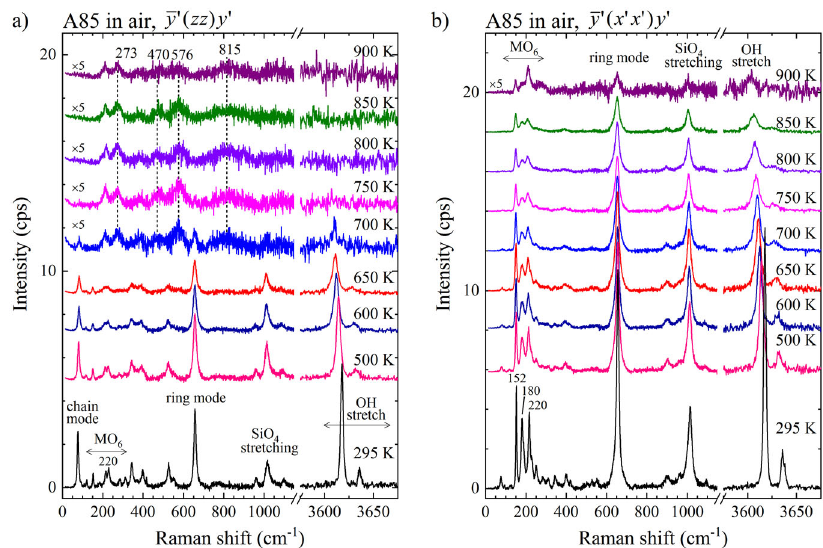
Fig. 2 Temperature-dependent polarized Raman spectra of grunerite A85 measured in situ in air. a Data collected in (cid:1) y 0 ð zz Þ y 0 scattering geometry; b data collected in (cid:1) y 0 ð x 0 x 0 Þ y 0 scattering geometry. The dashed lines trace the new Raman scattering signals appearing at 700 K in (cid:1) y 0 x 0 x 0 ð Þ y 0 spectra. The mode assignment follows the arguments given in refs. 27,52 . Spectra are vertically offset for